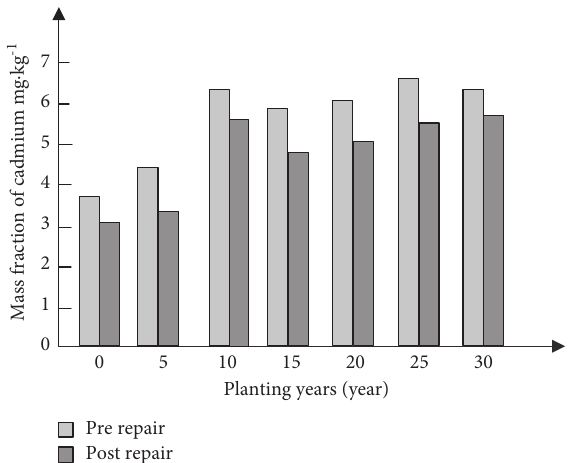
Figure 3: Effect of repair of greenhouse in different planting years of broom sedge vegetable soil cadmium.